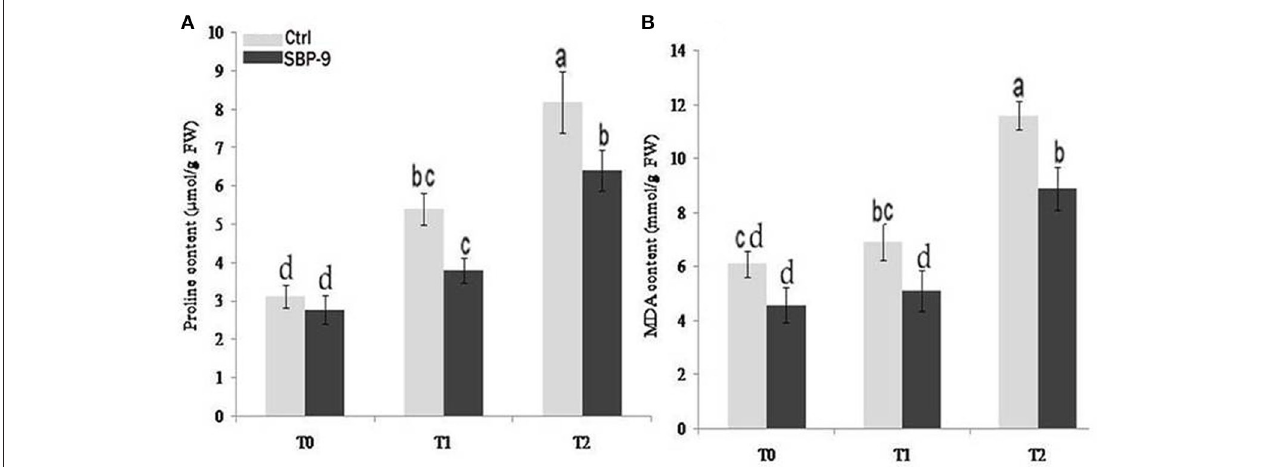
FIGURE 5 | Effect of SBP-9 inoculation on proline (A) and malondialdehyde content (B) under different treatments; T-0 (0mM NaCl), T-1 (150mM NaCl), T-2 (200mM NaCl). Values are mean ± SD of triplicate sets of five measurements in triplicate sets ( n = 15). Different letters on the bar in each column represent the significant difference.